Question: In a single sentence, describe what this figure presents.
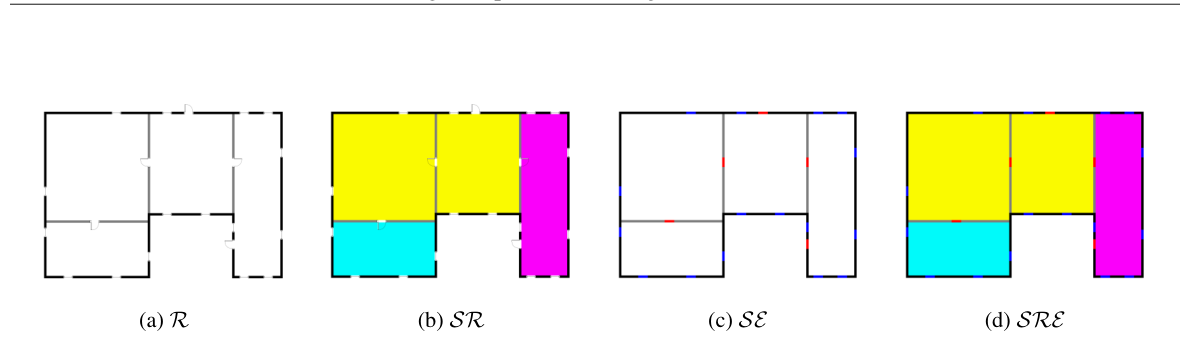
Answer: An example floor plan created by the procedural generation algorithm, rendered in each of the four encoding styles. Images like these are combined with a description prompt to be used as the training data for the four fine-tuning approaches.